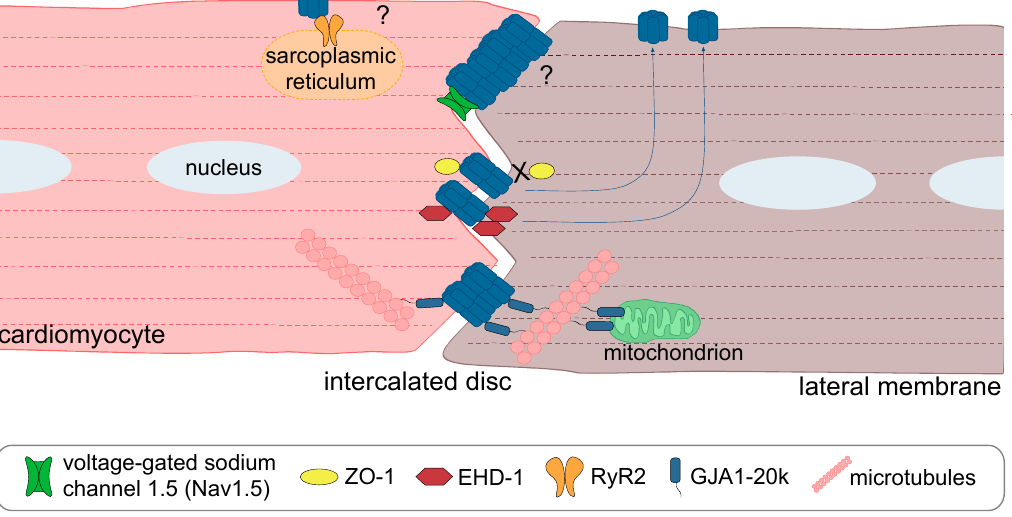
Figure 5. The cardiac Cx43 interactome alters in I / R-induced gap junction remodeling. A schematic representation of the subcellular localization of some relevant Cx43 interacting proteins in healthy (left; in pink) and injured (right; in brown) cardiomyocytes.